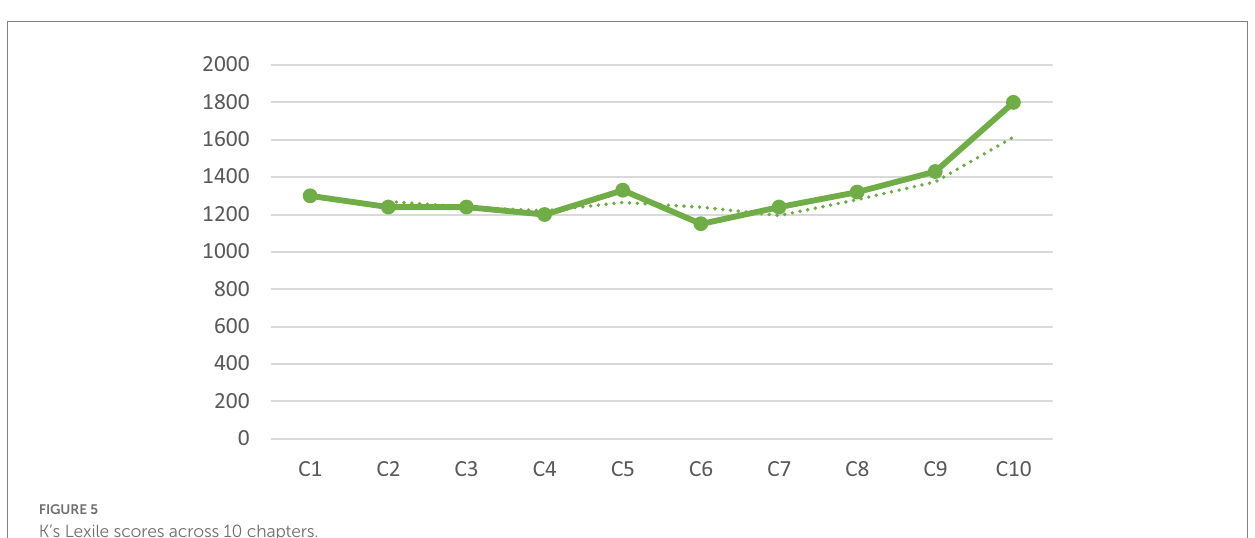
FIGURE 5 K’s Lexile scores across 10